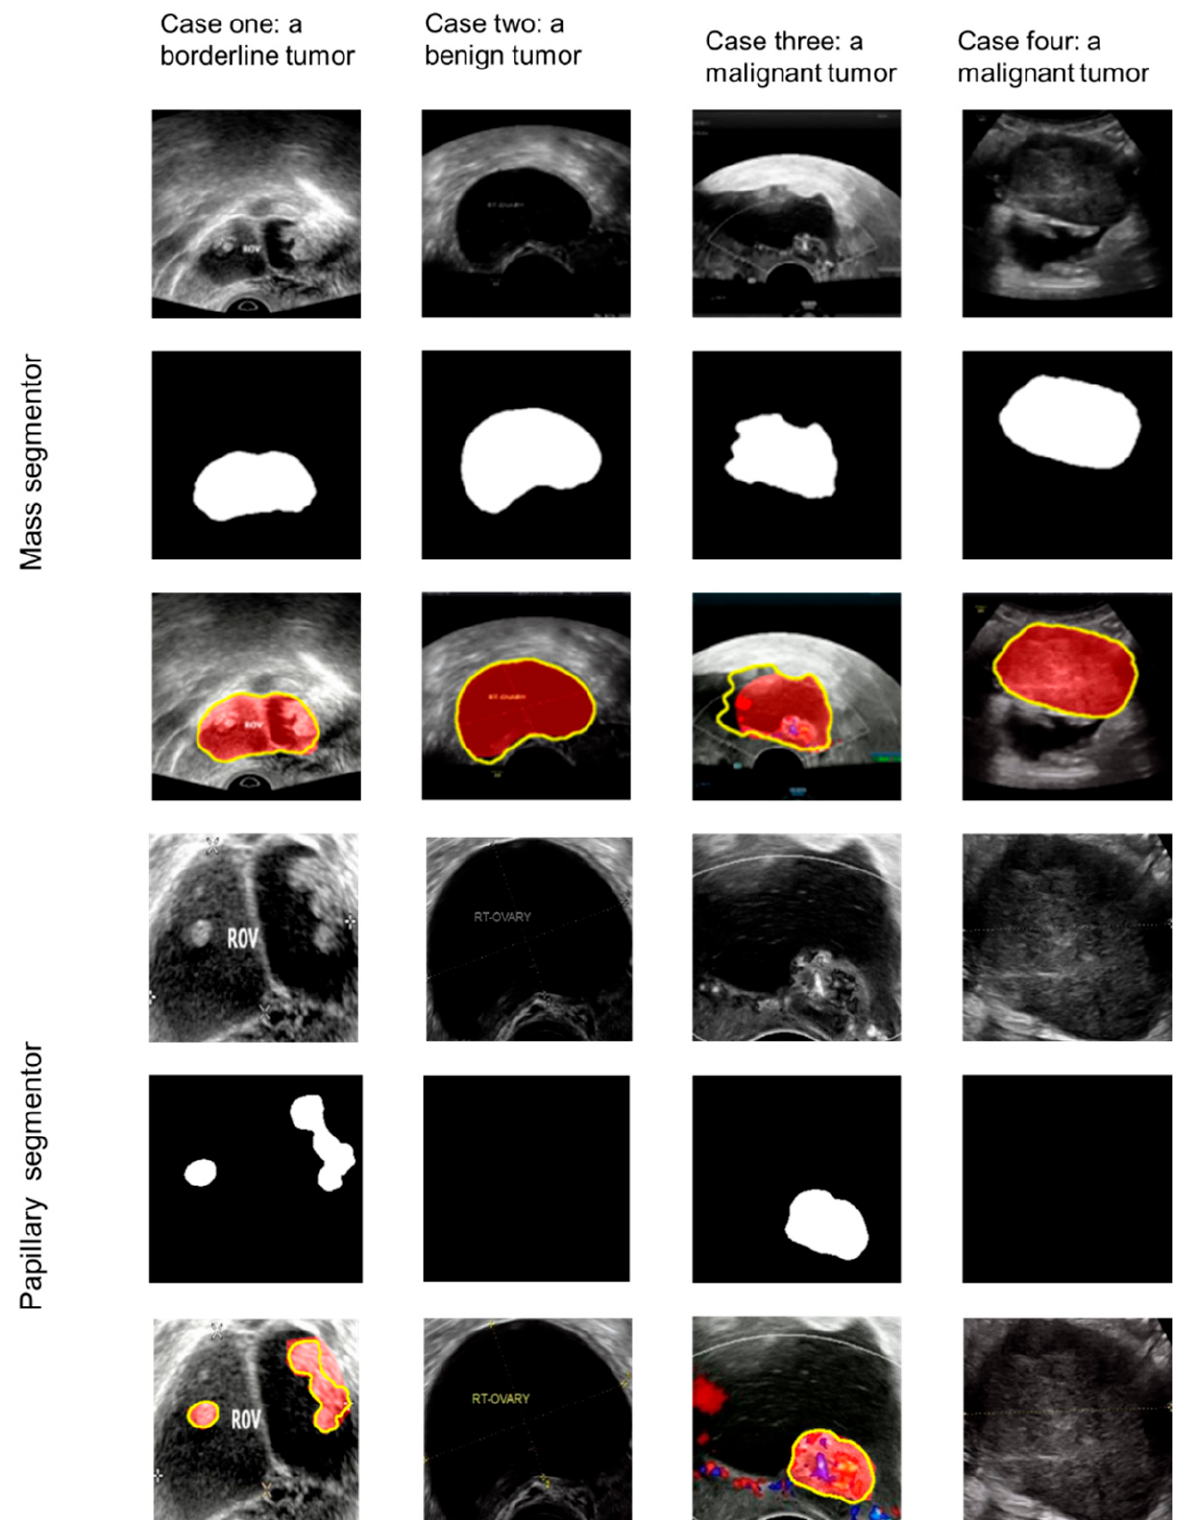
Figure 3. Case one shows a borderline tumor with papillary projections; case two shows a benign tumor without papillary projections; case three shows a malignant tumor with a papillary projection; case four shows a malignant tumor without papillary projections. The top three rows show the process of the mass segmentor; the three rows below show the process of the papillary segmentor. Yellow line: the result of the mass segmentor or the papillary segmentor; red area: ground truth.